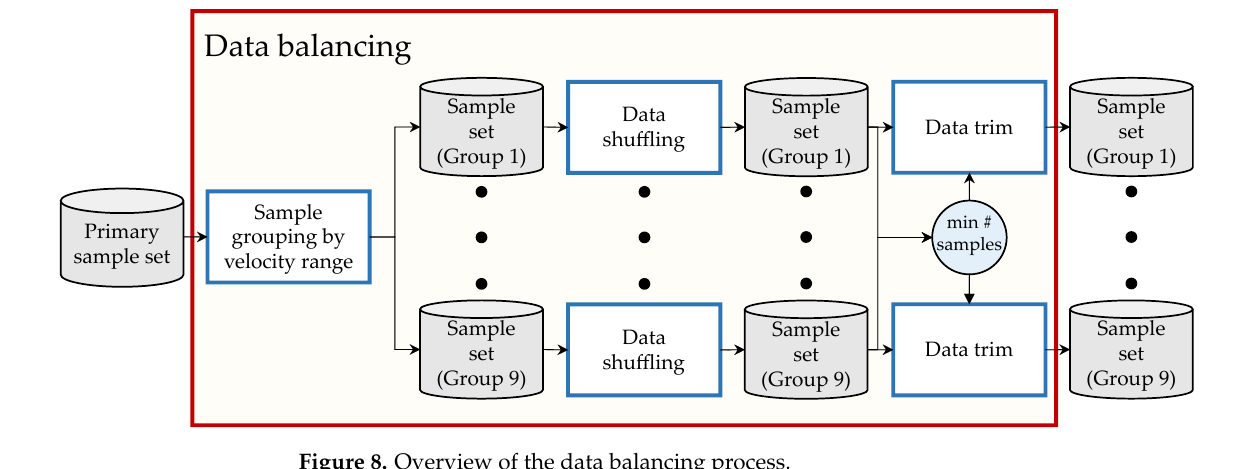
Figure 8. Overview of the data balancing process.